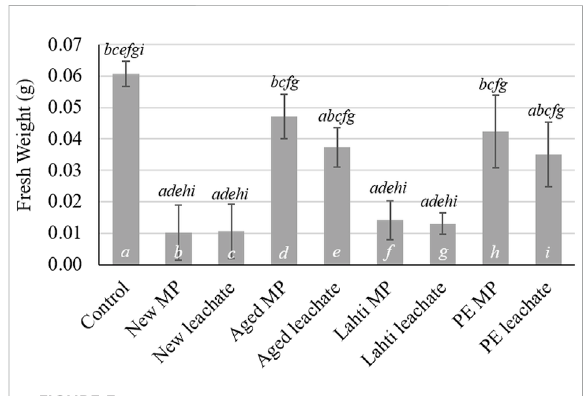
FIGURE 3 Ratio of the root and shoot lengths. Data represent mean ± standard deviation ( n = 24). Signi fi cant differences are indicated by the letter above the bars ( p < 0.05).